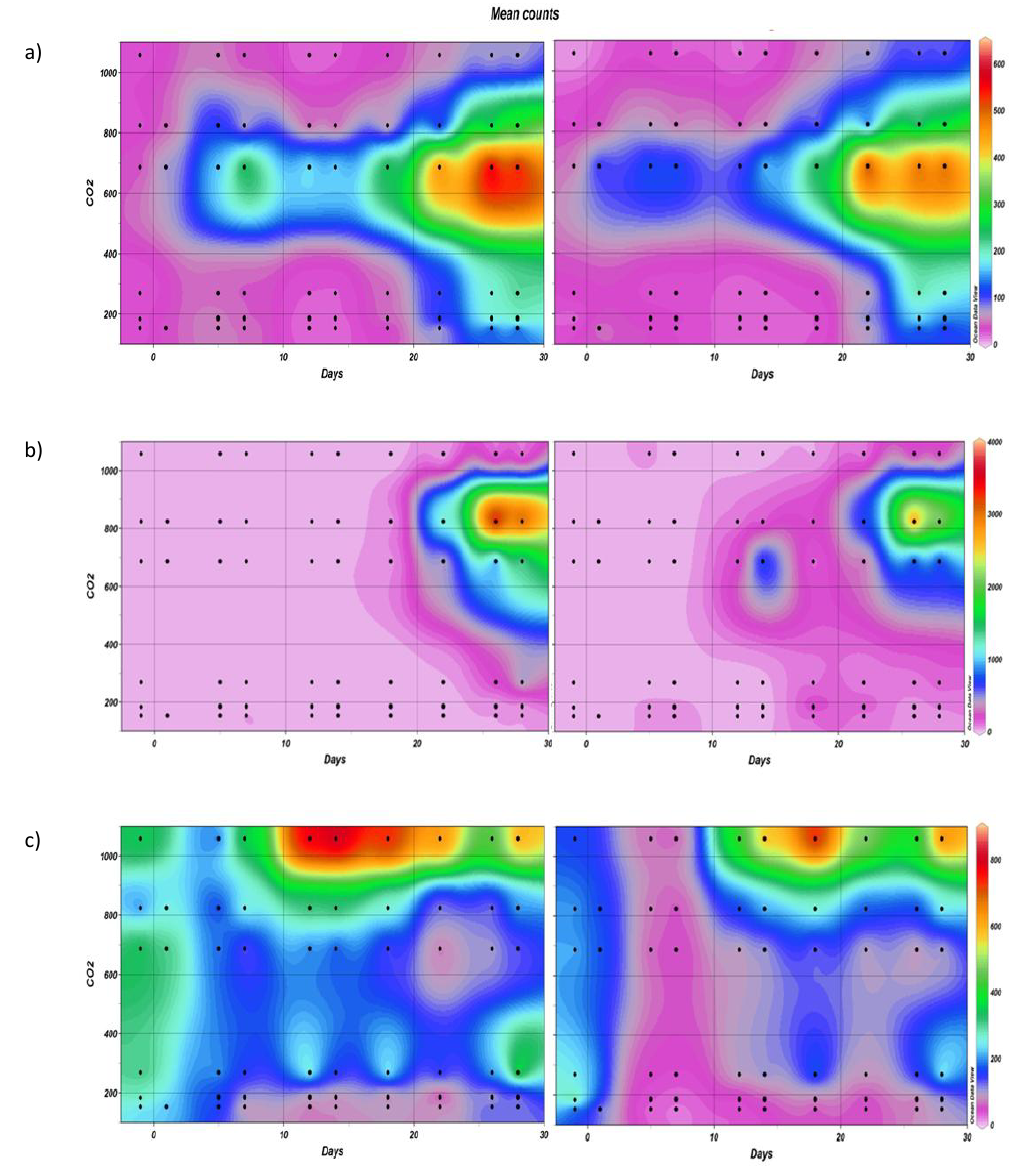
Fig. 4. Contour plots presenting the mean abundance count of the three most abundant taxa that are significantly affected by pCO 2 levels a) Methylotenera b) Colwellia and c) Fluviicola plotted against pCO 2 (µatm, y-axis) and time (days, x-axis). Left and right panel represent, respectively, the small fraction size (0.2-3 µ m) and large fraction size (3-20 µ m).